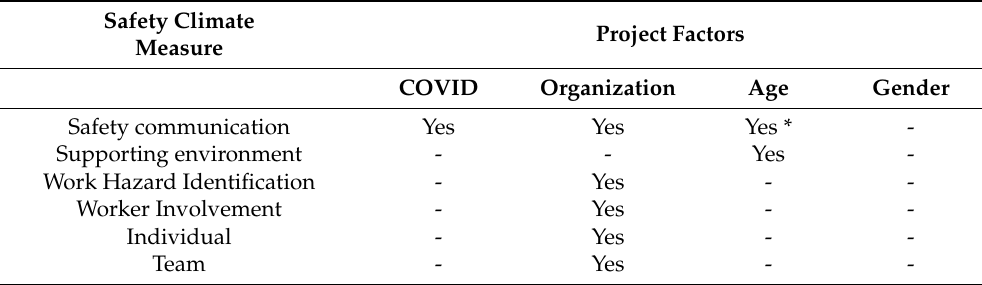
Table 8. Summary of Significance by Safety Climate Measure and Project Factors.